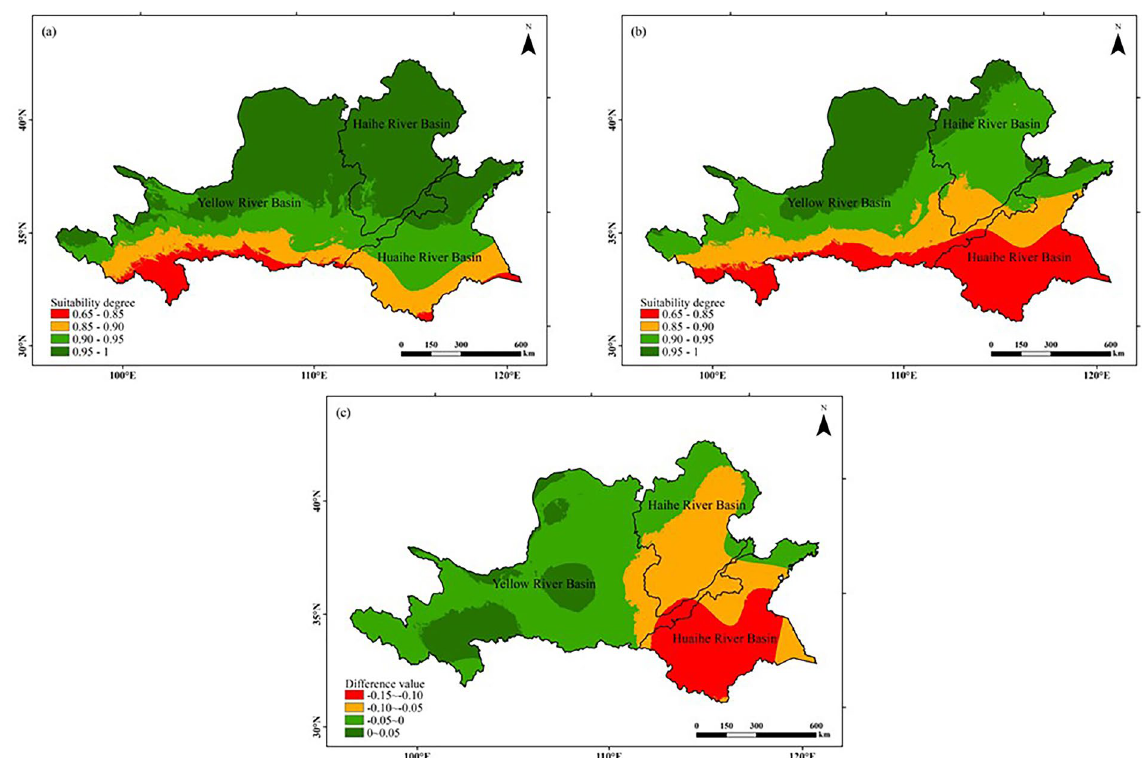
Figure 8. Comparison of the distribution of seasonal sunshine suitability for peanut growth in the Huang- Huai-Hai region during two climatic years: ( a ) 1960–1989, ( b ) 1990–2019, ( c ) ( b )–( a ). The figure was made in the ArcGIS 10.2 platform (https:// www. esri. com/ en- us/